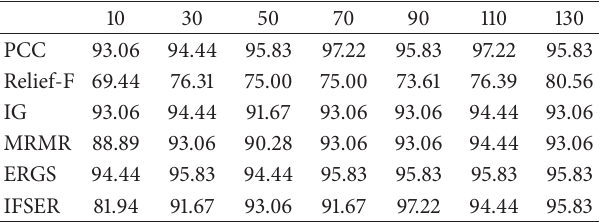
Table 6: Classification accuracies (%) of different feature selection methods with NN on Leukemia1 database.